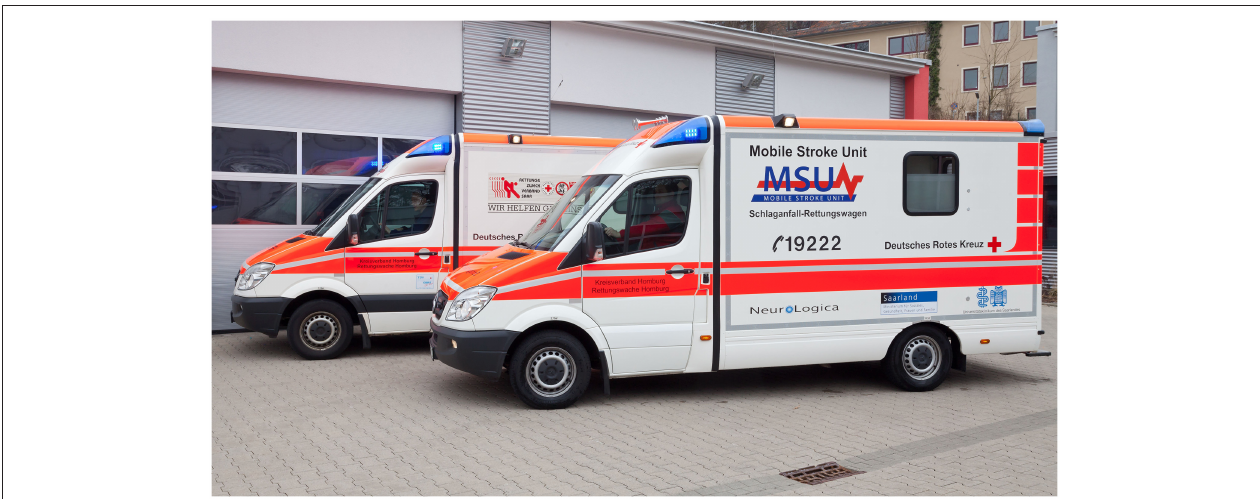
FIGURE 1 | Mobile Stroke Unit (MSU). The Mobile Stroke Unit is an ambulance which contains a multimodal CT scanner, a point-of-care laboratory, as well as a telemedicine system, which allows transfer of CT images and videos of patient examination for input from hospital specialists. Pictured is the MSU in Homburg, Germany.